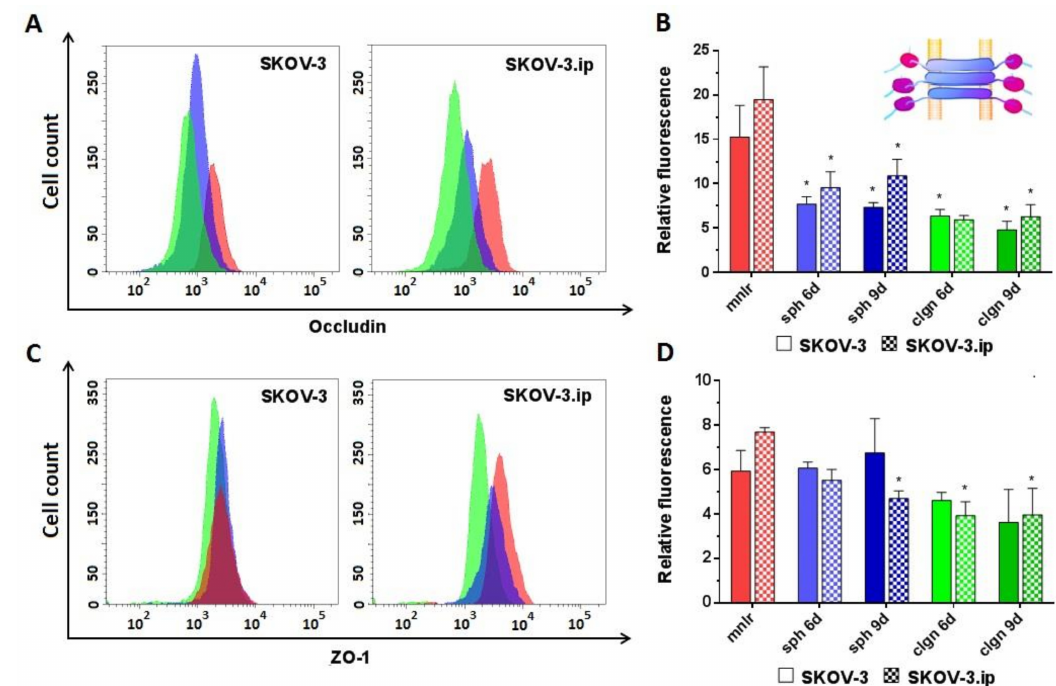
Figure 4. Expression level of analyzed proteins of tight junctions in SKOV-3 and SKOV-3.ip cells cultured in monolayer and 3D in vitro models. ( A , C ). The distributions of SKOV-3 cells (left plot) and SKOV-3.ip cells (right plot) according to fluorescence intensity detected after staining with occludin-specific and ZO-1-specific antibodies (red—monolayer culture, blue—spheroids, green—collagen hydrogel); ( B , D ) Expression levels of occludin and ZO-1 in monolayer and 3D models denoted as relative fluorescence values calculated as a ratio of mean fluorescence intensity of cells stained with specific antibodies to mean fluorescence intensity of cells stained with antibodies of isotypic control. mnlr , monolayer; sph , spheroids, clgn ; collagen hydrogel. “*” indicates significant di ff erence in RF level